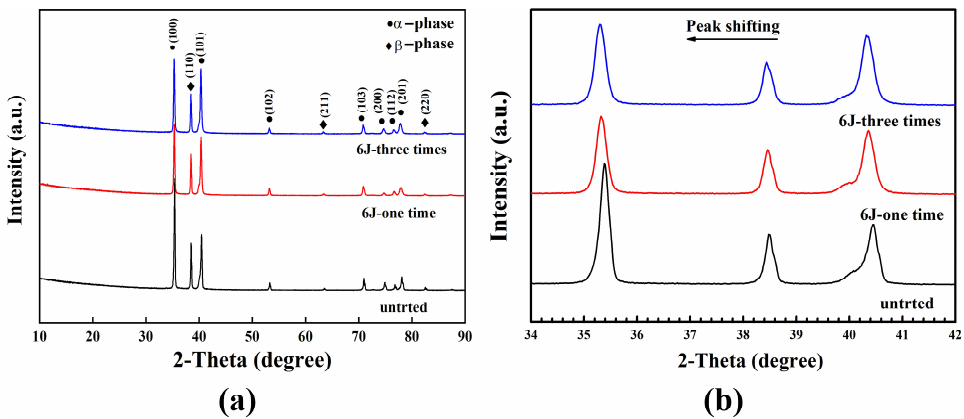
Figure 4. ( a ) XRD patterns of Ti-13Nb-13Zr coupon surfaces before and after the LSP treatment with 6J-1time and 6J-3times; ( b ) diffraction peak shifting for α (100), β (110) and α (110) planes.